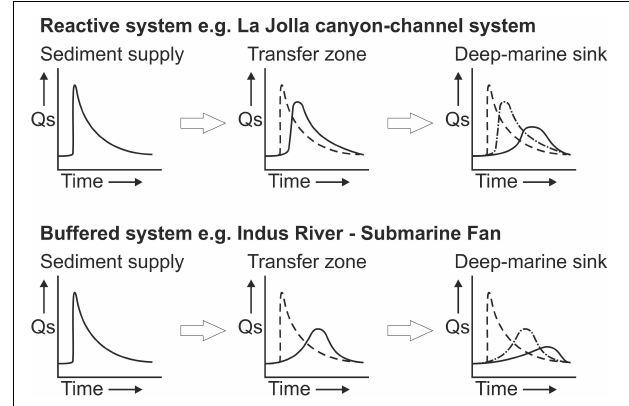
FIGURE 6 | Reactive versus buffered sediment delivery systems. Longer residence periods for sediment in the buffered systems suggests that plastics may be more degraded, both physically and chemically, suggesting that plastics delivered in these systems will be more degraded and smaller. In the buffered example, the seafloor expression of surges in plastic production may significantly lag behind their introduction to the sedimentary environment. Modified from Romans et al.